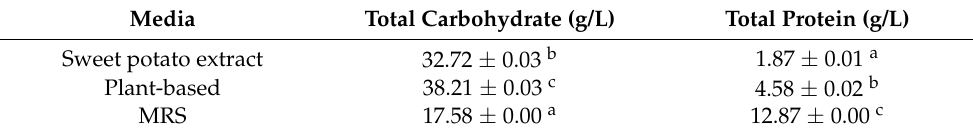
Table 3. Total carbohydrate and protein of media.